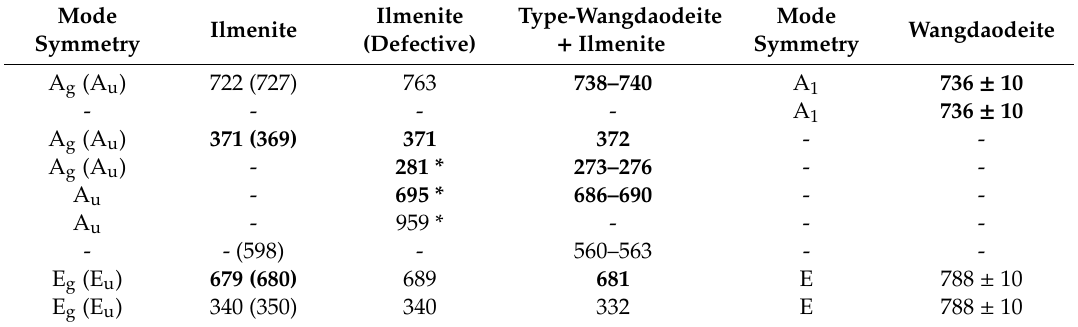
Table 5. Raman and IR-active bands of ilmenite, defective ilmenite, and wangdaodeite above 270 cm − 1 . Energies are given in cm − 1 . The * marks silent modes. In brackets: ilmenite observed, Rru ff #06149. Data for type wangdaodeite and coexisting shocked ilmenite are taken from Xie et al.